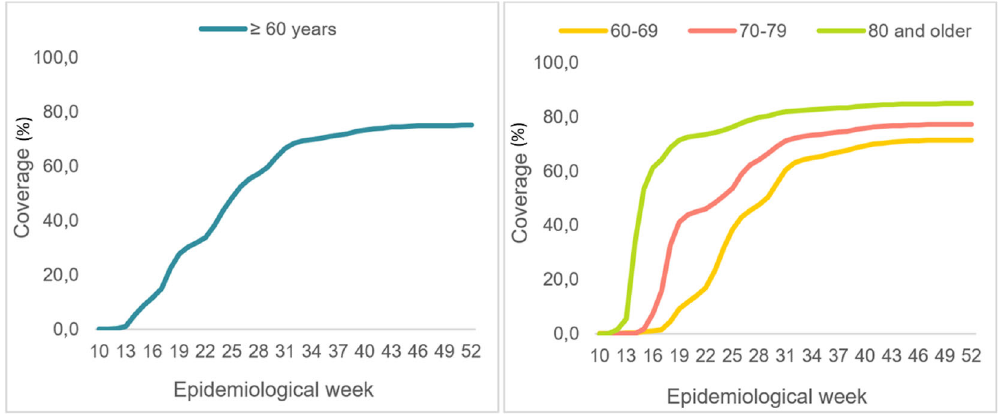
Figure 1. Evolution of full COVID-19 vaccination coverage for older adults. Colombia. Epidemiological weeks 10 to 52, of